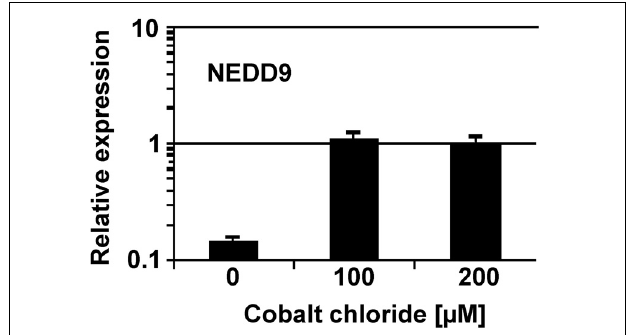
FIGURE 2 | Expression of NEDD9 in SH-SY5Y cells. Expression of NEDD9 was analyzed in SH-SY5Y cells under different culture conditions by qRT-PCR. Cells were cultured in absence of CoCl 2 (water control), with 100 µ M of CoCl 2 or with 200 µ M of CoCl 2 . Presented are means and standard deviations from three independent experiments. For comparative analysis, beta actin was used as housekeeping control and the median expression of all samples was set as